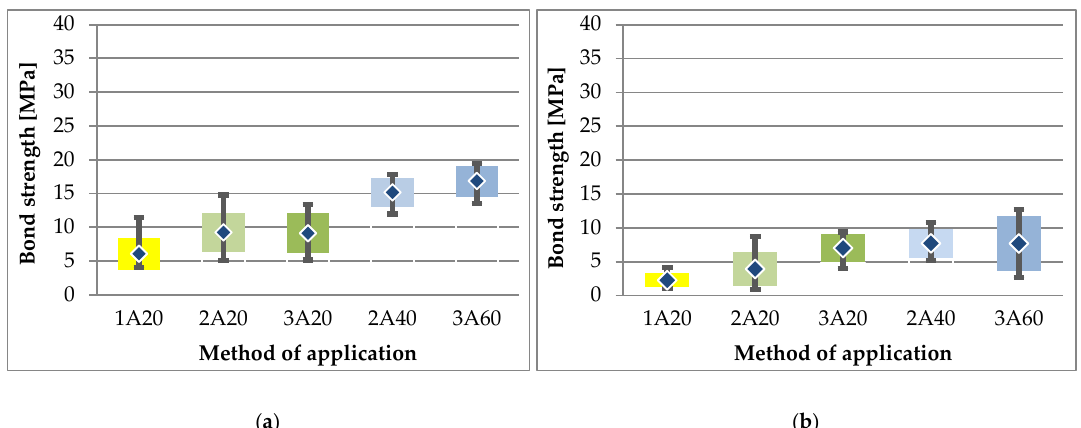
Figure 10. SBS results of self-etch adhesives: ( a ) Adper Easy One; ( b ) Xeno V.